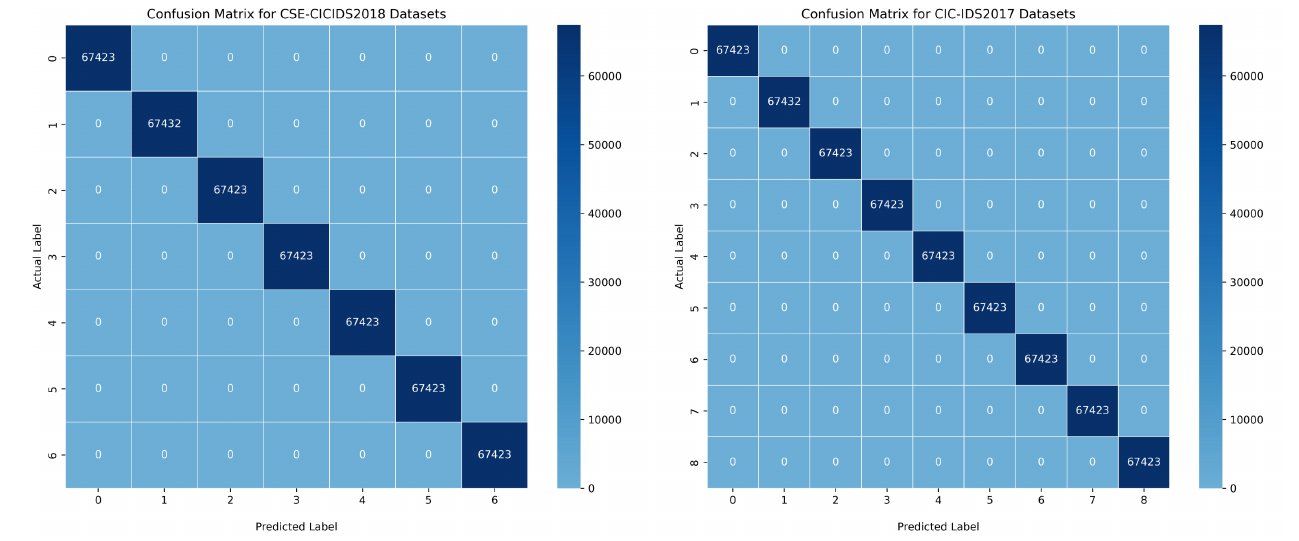
Figure 7. Confusion matix for proposed